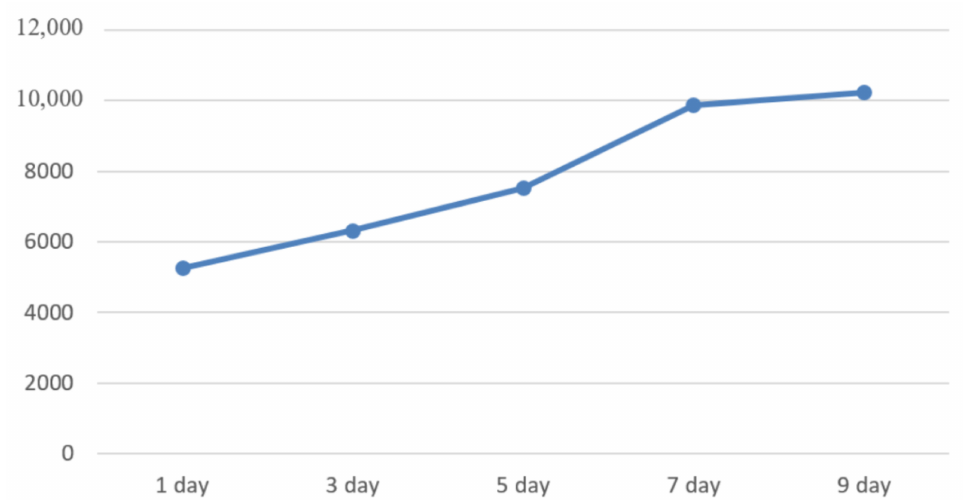
Figure 10. Statistical chart of trend changes in data interaction volume.